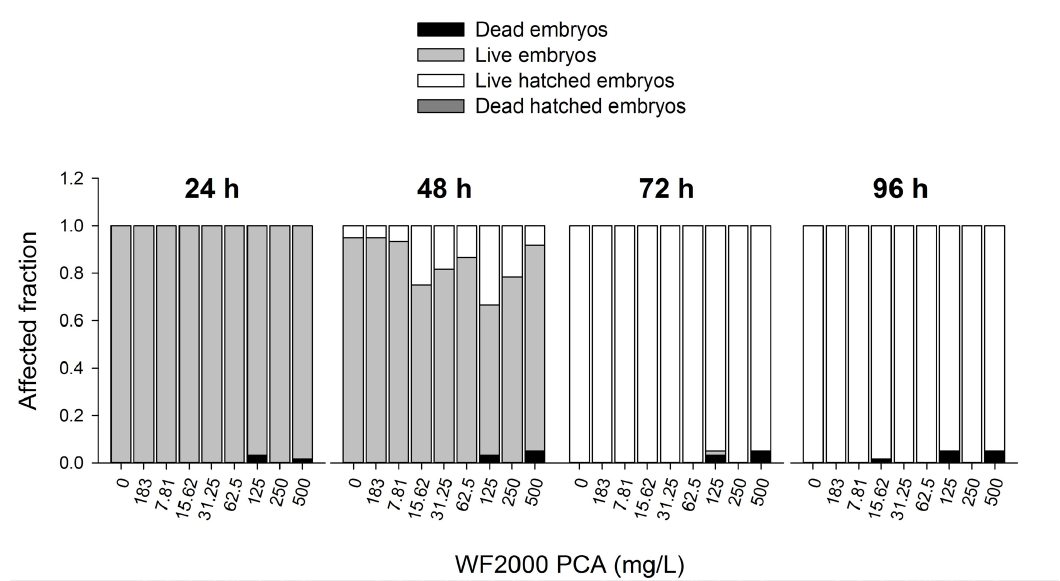
Figure 2. showing an overview of zebrafish embryo toxicity test after 96 h of exposure to WF 2000 PCA. The proportion of eggs and non-hatched embryos that died are represented by black bars; the proportion of embryos that stayed alive but did not hatch are presented as grey bars; those that hatched as white bars and the proportion of embryos that died after hatching as spotted, dark dashed grey